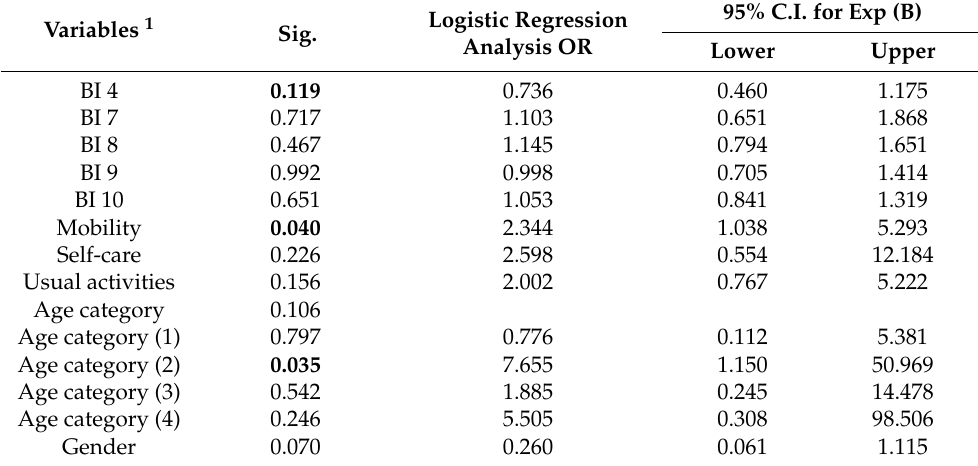
Table 5. Results of predictors for frailty in elderly CVD group.